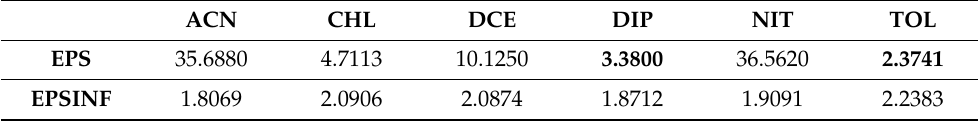
Table 2. Static and optical dielectric constants (a) of the solvents used in the present work. ACN CHL DIP